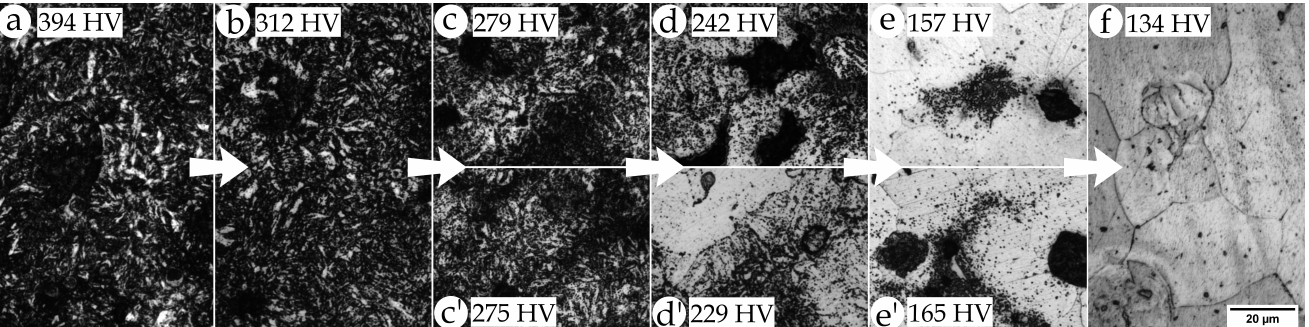
Figure 8. Evolution of hardness with the tempering parameter ( a ) TP = 14.1, group 1, 10 min at 500 ◦ C. ( b ) TP = 15.9, group 1, 10 min at 600 ◦ C. ( c ) TP = 17.9, group 1, 24 h at 500 ◦ C. ( c’ ) TP = 17.5, group 1, 1 h at 600 ◦ C. ( d ) TP = 17.7, group 1, 10 min at 700 ◦ C. ( d’ ) TP = 17.7, group 3, 10 min at 700 ◦ C. ( e ) TP = 19.5, group 1, 1 h at 700 ◦ C. ( e’ ) TP = 19.5, group 2, 24 h at 600 ◦ C. ( f ) TP = 22.6, group 1, 24 h at 700 ◦ C. All figures at ×